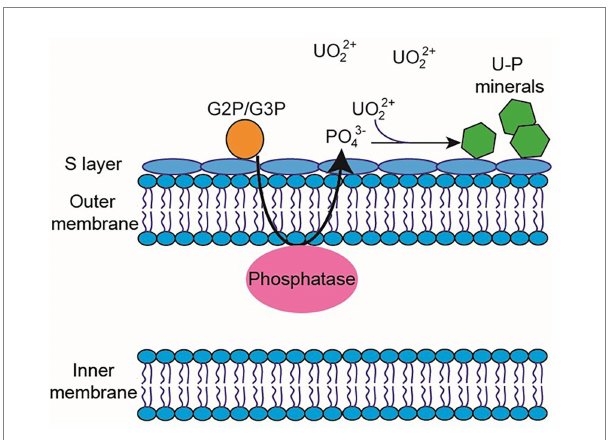
FIGURE 8 Diagram of the periplasmic phosphatase-mediated biomineralization process. Phosphatase releases inorganic phosphate from an organic phosphate source (e.g., G2P/G3P) to interact with U VI and produce the precipitation of uranium